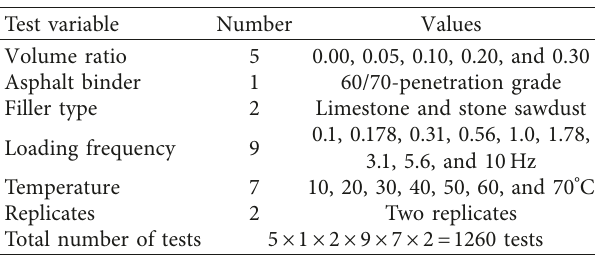
Figure 3: Sample sandwiched between the two plates. Table 3: Testing matrix.